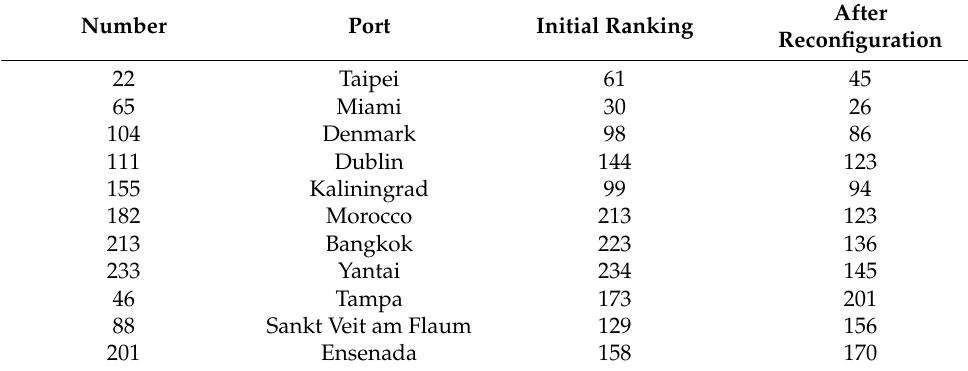
Table 8. Port centrality score